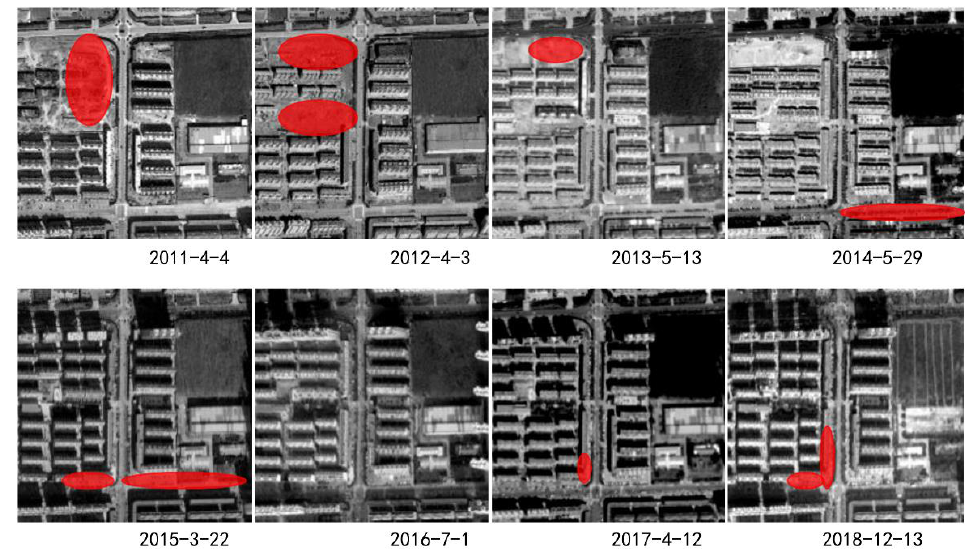
Figure 8. Evolution process of Tong Yin fairs in 2011–2018 (Source: Own drawing).